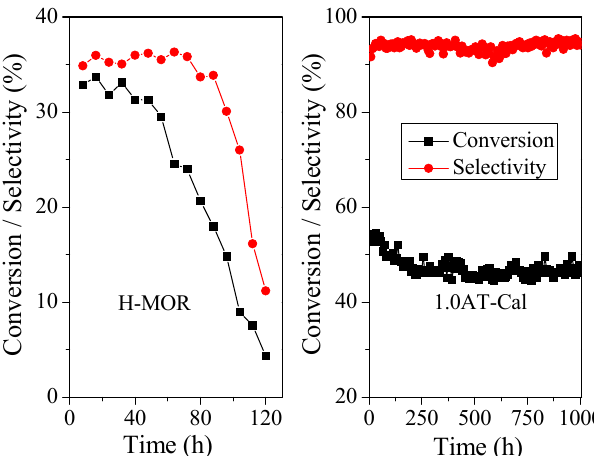
Figure 9. Catalytic lifetime of alkali treated H-MOR in selective synthesis of EDA. Reaction conditions: H-MOR: temperature = 320 °C, pressure = 4.0 MPa, NH 3 /MEA (mol/mol) = 21/1, LHSV = 4.58 h − 1 ; 1.0AT-Cal: temperature = 280 °C, pressure = 4.0 MPa, NH 3 /MEA (mol/mol) = 12/1, LHSV = 4.58 h − 1 .